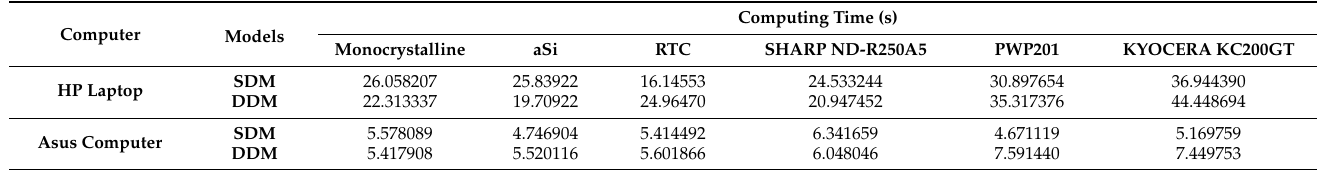
Figure 7 . Kyocera KC200GT photovoltaic panel: ( a ) measured and calculated I-V characteristic for SDM; ( b ) measured and calculated I-V characteristic for DDM; ( c ) SDM and DDM errors comparison. Table 20. Computing time-based analysis with two computers with distinct features.